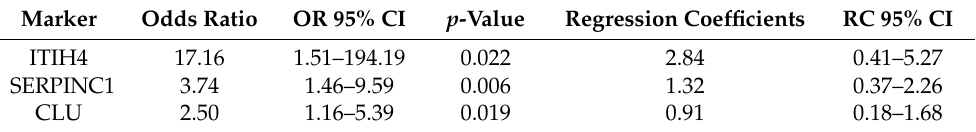
Table 2. Multivariate logistic regression model for EC biomarkers using serum protein levels and resulting after the step-down procedure; only significantly associated variables are kept ( p < 0.05).